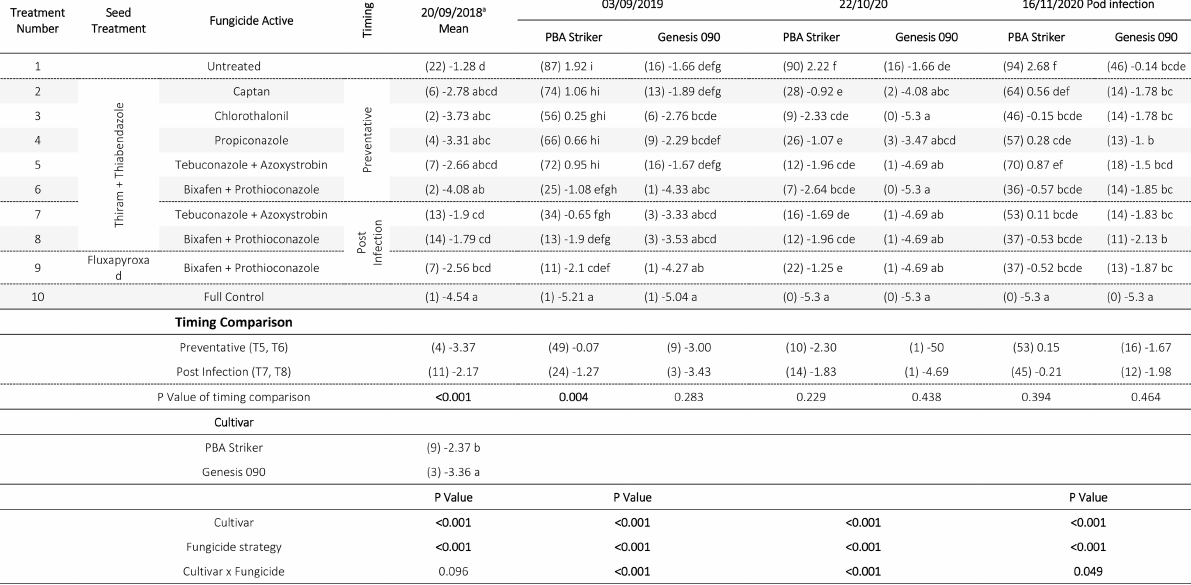
Data are logit transformed with values in parentheses showing back-transformed means. Significant pairwise differences between cultivar or fungicide treatment within an experiment (year) do not have letters in common.